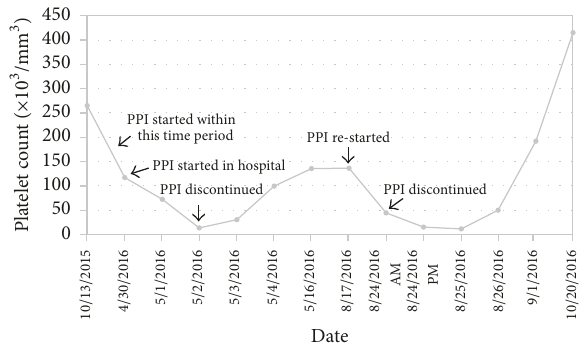
Figure 1: Platelet count trend of the patient. Thrombocytopenia developed after starting PPI for the first time and later on when it was restarted. Platelet count recovered after PPI was discontinued on both occasions ( 𝑥 -axis: actual date; 𝑦 -axis: platelet count in 10 3 /mm 3